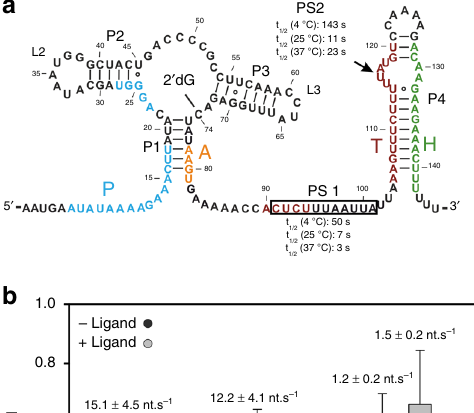
effect of ligand addition on the fraction of ON state obtained is signi fi cantly more pronounced with 40 – 50% change in popula- tion ratio opposed to ~20% for single-round transcriptions (Fig. 5c). For transcription reactions performed at 4 °C, ligand addition does not cause signi fi cant changes in the population of ON state for both single-round and multi-round transcription. For the B . subtilis RNAP, transcription rates could only be determined at 37 °C due to insuf fi cient transcription ef fi ciency at lower temperatures. Transcription rates for B . subtilis RNAP are − 1 ) (Supplemen- higher compared to E . coli RNAP (34.7 ± 30.7 nt s tary Fig. 7). In addition, the decrease in ON state population upon addition of ligand is signi fi cantly less pronounced. At an NTP concentration of 2.3 mM, ligand addition only induces a 5% shift in the fraction of ON state. Contrary to the behavior of E . coli polymerase, a decrease in the NTP concentration to 0.05 mM increases the ligand-induced shift in the fraction of ON state to 21%. NATURE COMMUNICATIONS | (2018) 9:944 | DOI: 10.1038/s41467-018-03375-w |